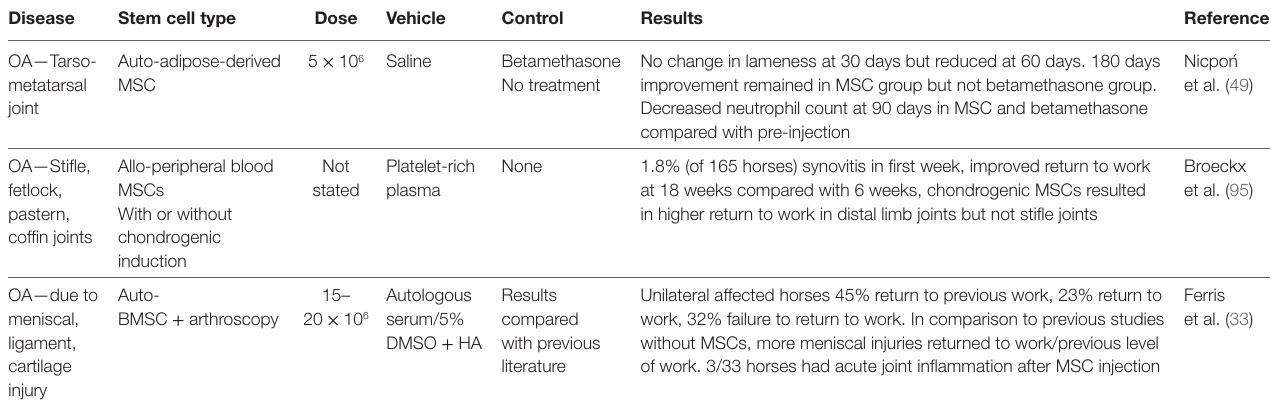
TABLe 2 | Clinical trials using culture-expanded mesenchymal stem cells (MSCs) for OA in horses.